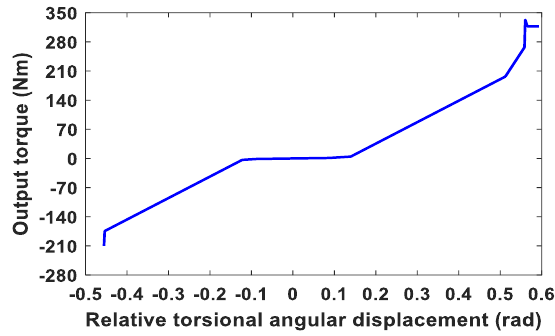
Figure 3. Torsional stiffness characteristic curve.